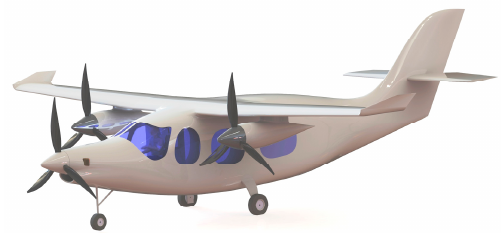
Figure 4. Conceptual prototype “Skybrid” hybrid electric skydiving/freight aircraft.